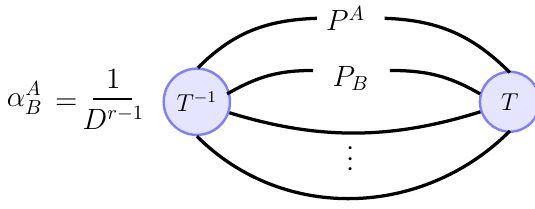
Figure 3. Linear part of operator pushing coe(cid:14)cient